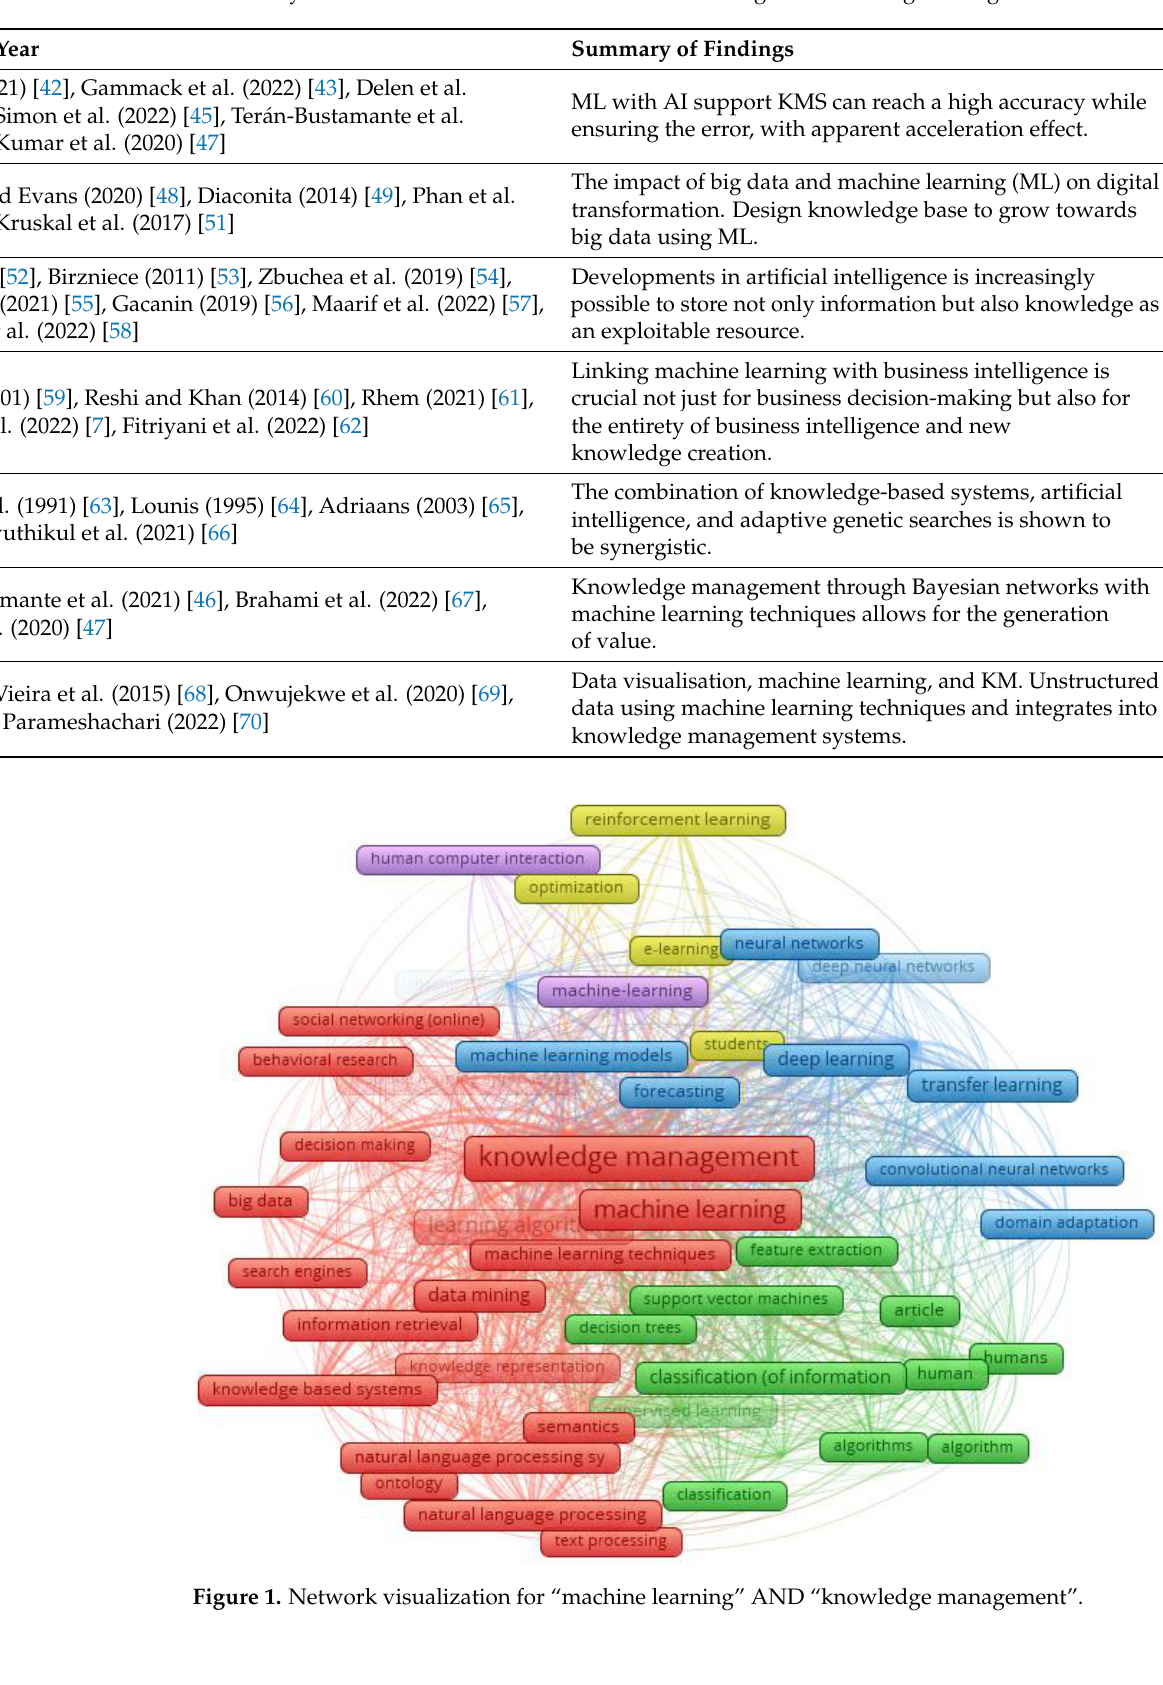
Table 1. Systematic literature review for machine learning and knowledge management.